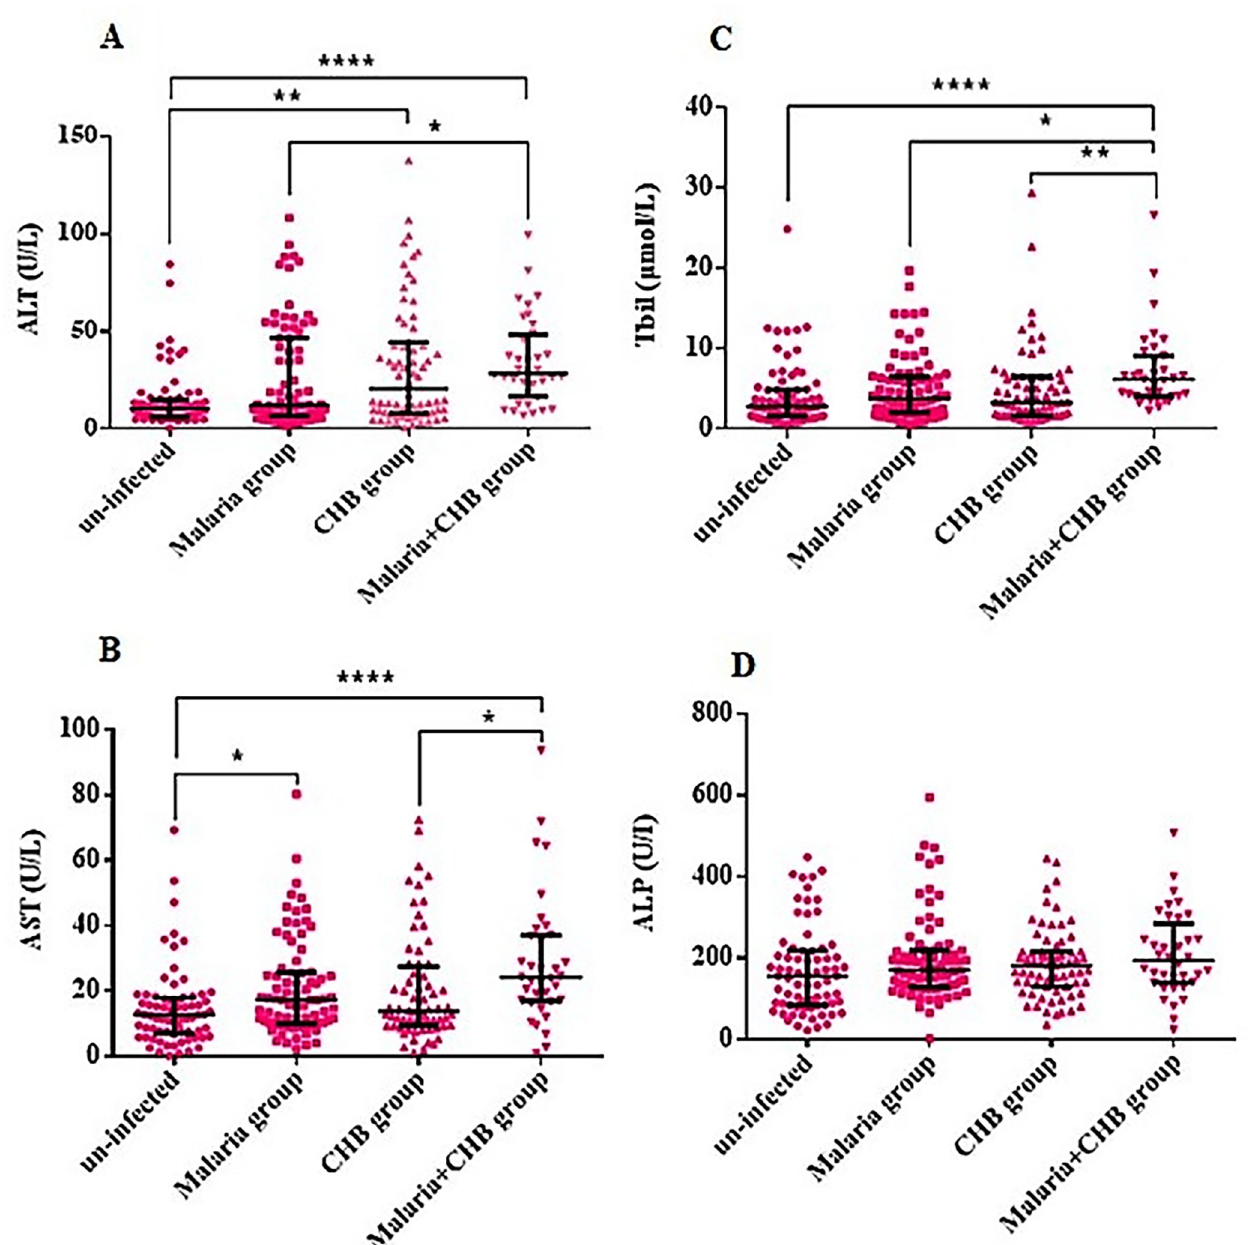
Fig 2. Differences in levels of liver biochemical parameters across the different categories of pregnant women. Dunn’s multiple comparison tests for pair-wise differences in serum levels of (A) alanine aminotransferase (ALT), (B) aspartate amino transferase (AST), (C) total bilirubin (Tbil) and (D) alkaline phosphatase (ALP). Significant P-values were observed at � P < 0.05, �� P < 0.01 and ���� P < 0.0001. Horizontal bar with error bars represents the median and the interquartile range respectively.